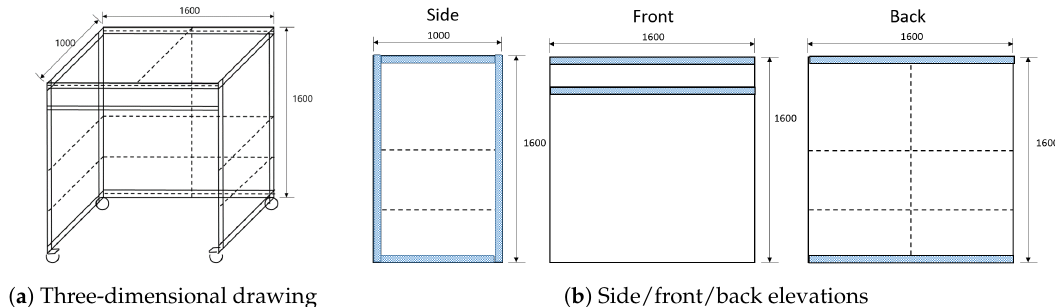
Figure 5. Sensor frame design. The frame is a 1.6 m (w) × 1. 6m (h) × 1.0 m (d) sized cuboid-shaped aluminum frame equipped with large wheels, which has been designed to sufficiently be robust against internal and external